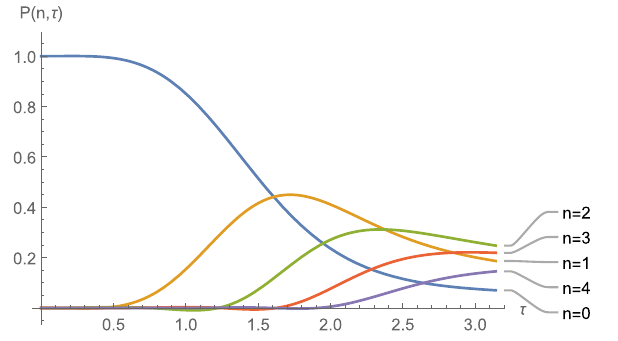
Figure 3. The probability P n (τ) (see Eq. (39)) for n = 0, 1, 2, 3, 4 is depicted for the values k 0 = ω 0 , φ I = 0.1 ω 0 , and ν = 0.9 ω 0 in terms of the dimensionless variable τ = ω 0 t